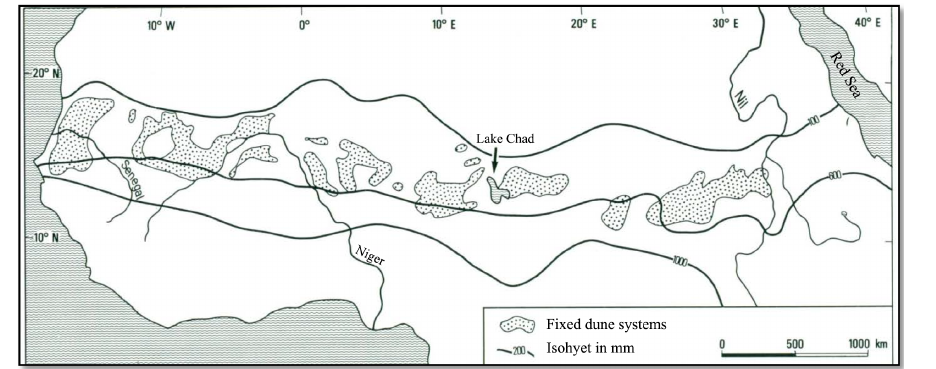
Figure 7. Position of late Quaternary dune systems in the Sahel according to Mensching